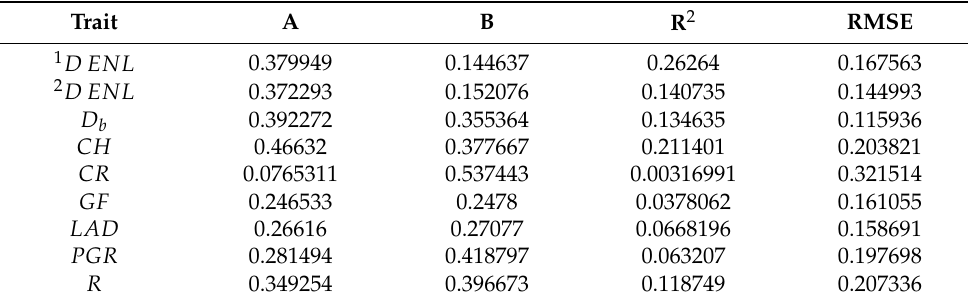
Table A12. Overview linear regression between TLS and ULS at 1m grid